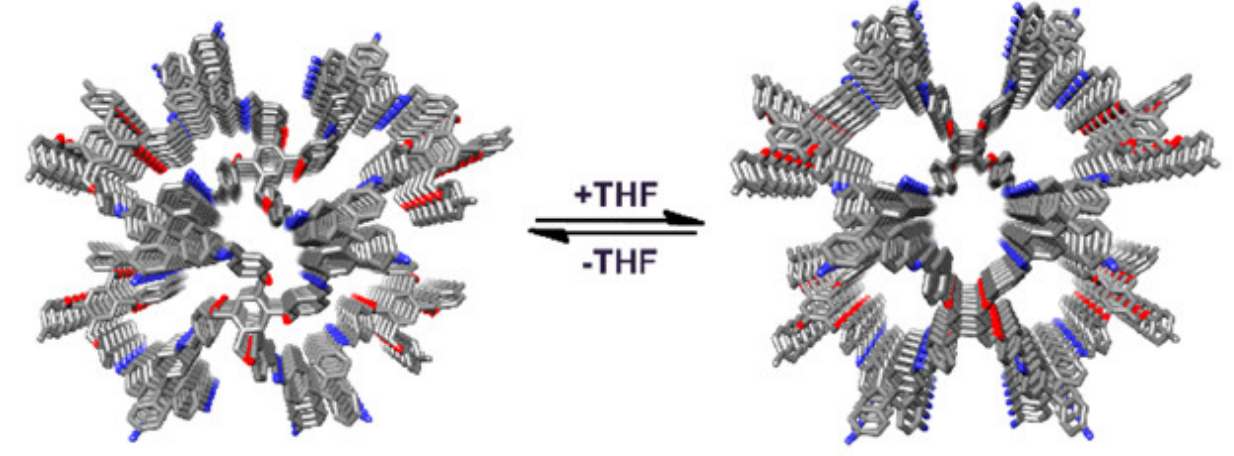
Figure 10. Flexible 3D COF in presence of an organic solvent Reprinted (adapted) with permission from [49]. Copyright 2021 American Chemical Society.